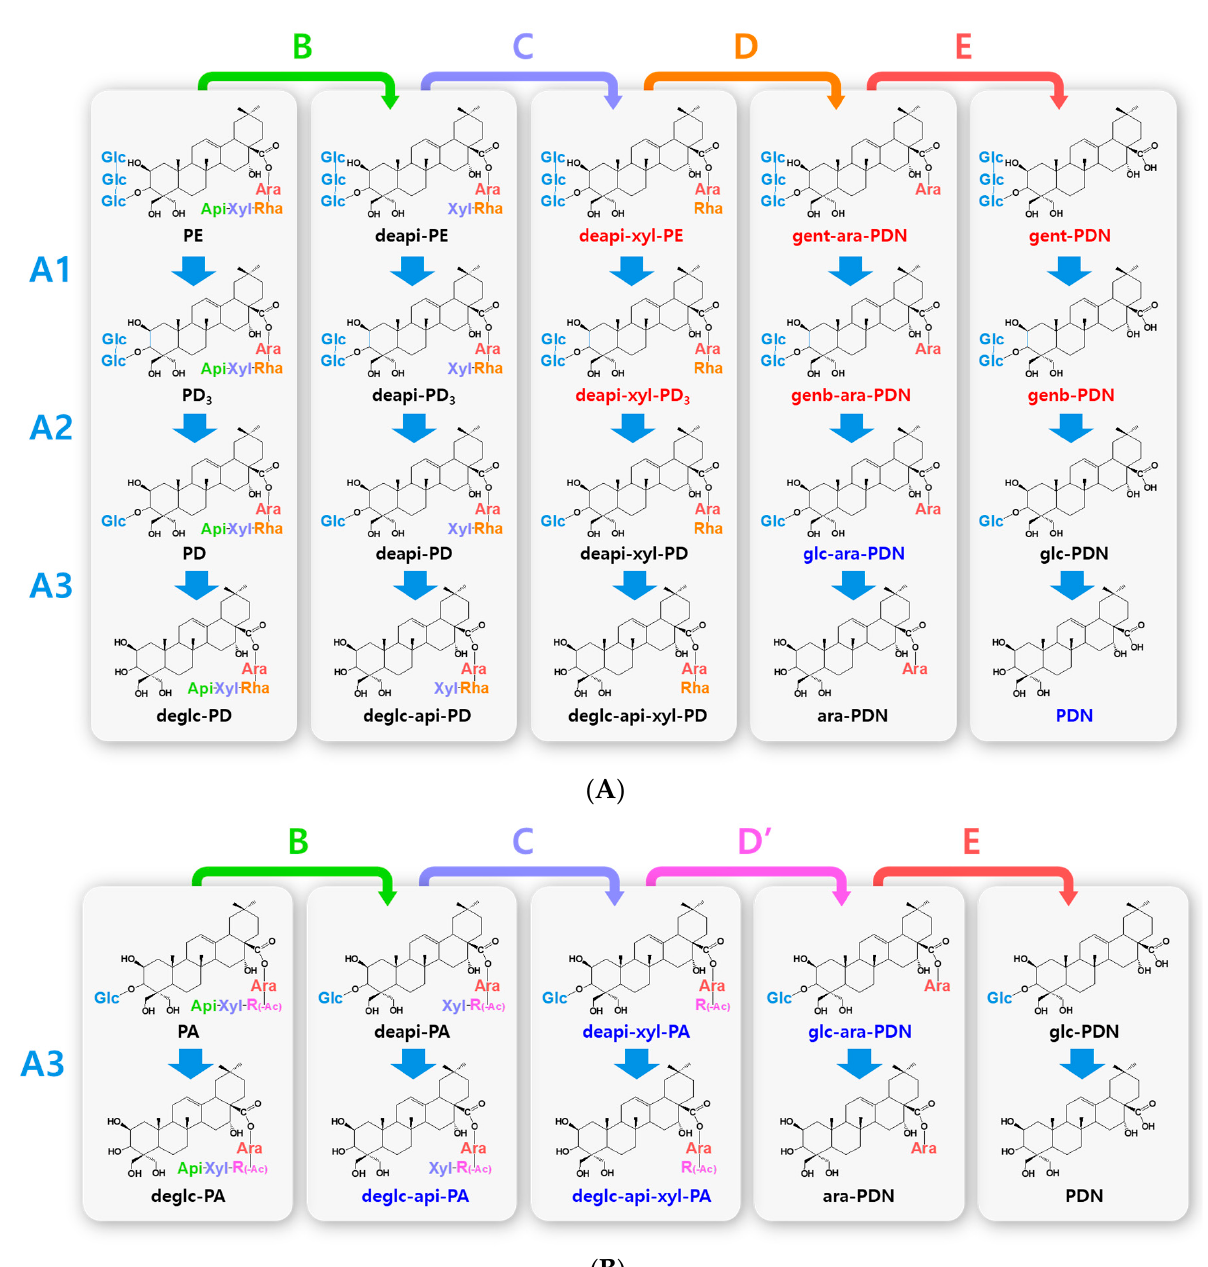
Figure 2. Hydrolytic pathways of the PDN-type platycosides by glycosidases. The hydrolytic pathways of the outer, middle, and inner glucoside residues linked to C-3 by β - D -glucosidases are assigned as A1, A2, and A3, respectively. The hydrolytic pathways of the four residues, including apioside, xyloside, rhamnoside or acetyl-rhamnoside, and arabinoside, linked to C-28 in PDN-type platycosides by β - D -apiosidase, β - D -xylosidase, α - L -rhamnosidase, and α - L -arabinosidase are assigned as B, C, D or D ′ , and E, respectively. ( A ) Hydrolytic pathways from PE to PDN. ( B ) Hydrolytic pathways from PA to PDN. R(-Ac), acetyl- α - L -rhamnopyranosyl-. Blue indicates unreported platycosides, which can be suggested by the reported glycosidases. Red indicates unreported platycosides, which cannot be suggested by the reported glycosidases.